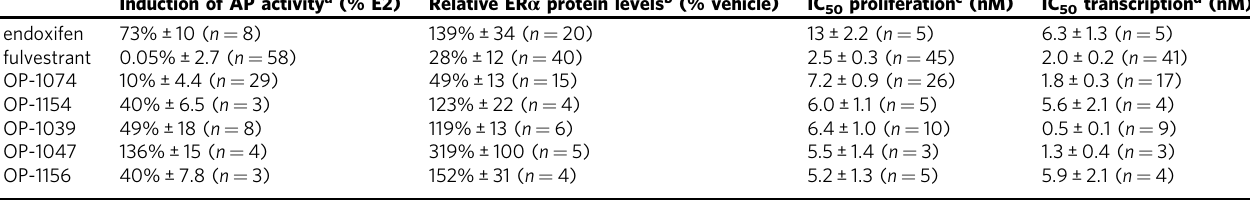
Table 1 Summary of data for in vitro assays Induction of AP activity a (%